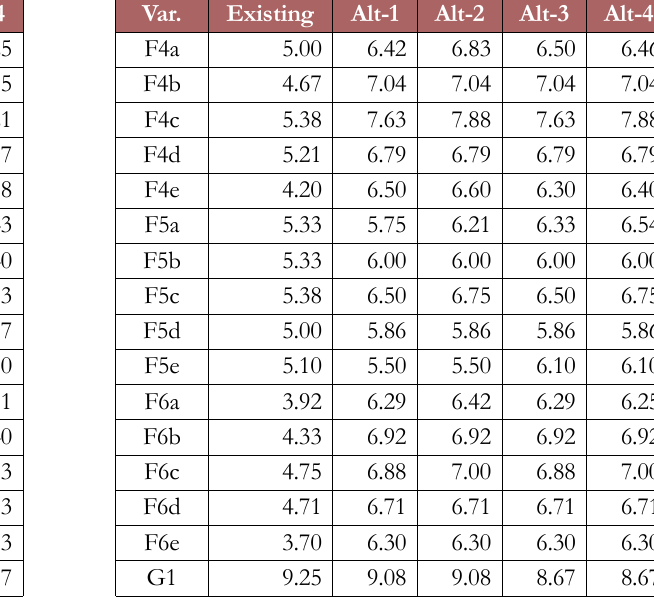
Table 6. Result of Data Collection